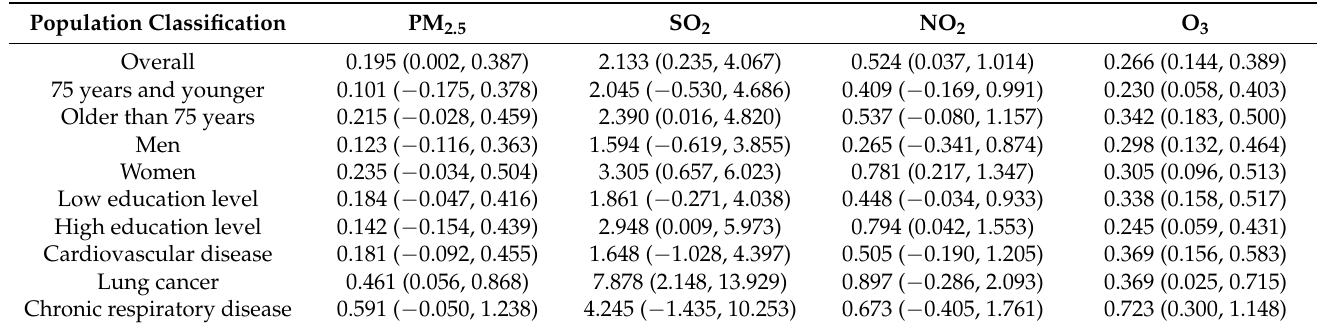
Table 2. Effects of air pollutants on the daily mortality of various populations in Beijing